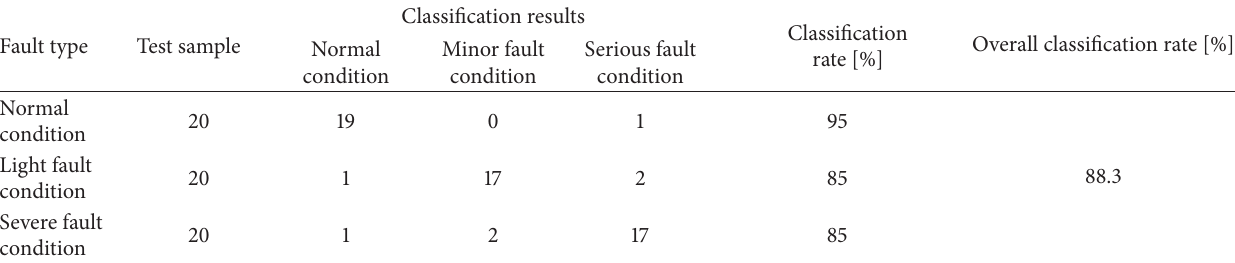
Table 4: Fault diagnosis using the approach based on CEEMD and